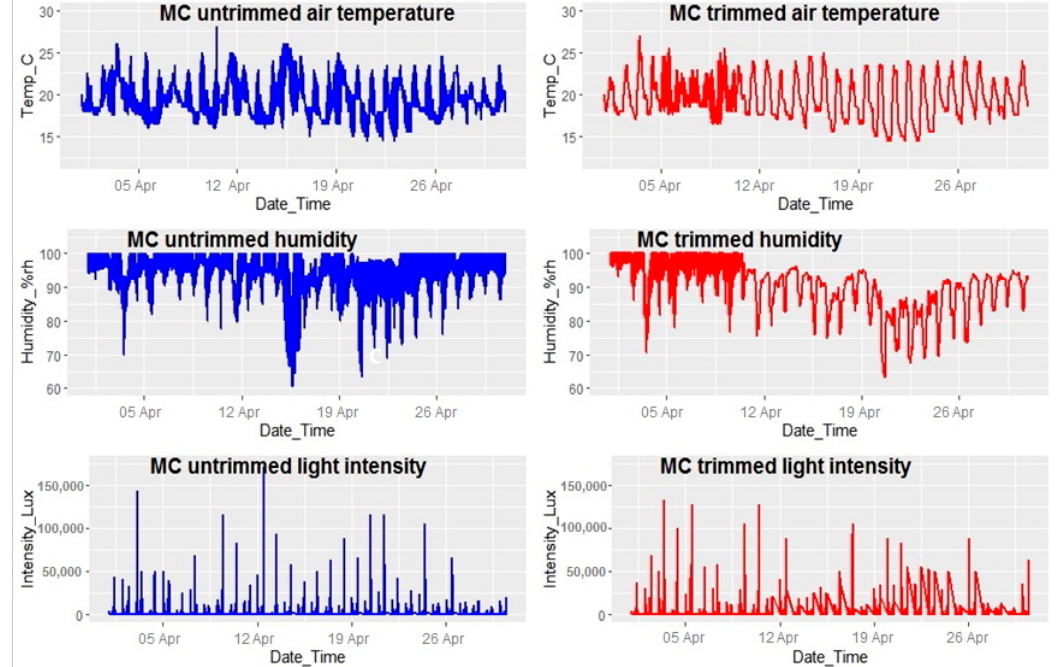
Figure 6. Example datasets collected from air temperature, humidity and light level sensors during April 2021 from the MC trimmed and untrimmed plots, showing daily cycle of all 3 parameters. In each treatment block there are 3 air temperature and humidity sensors, 5 light sensors, 5 soil temperature sensors, and 3 soil moisture sensors positioned randomly within the central area of each plot (excluding the outer 10 m buffer zone). These record a measurement every hour.